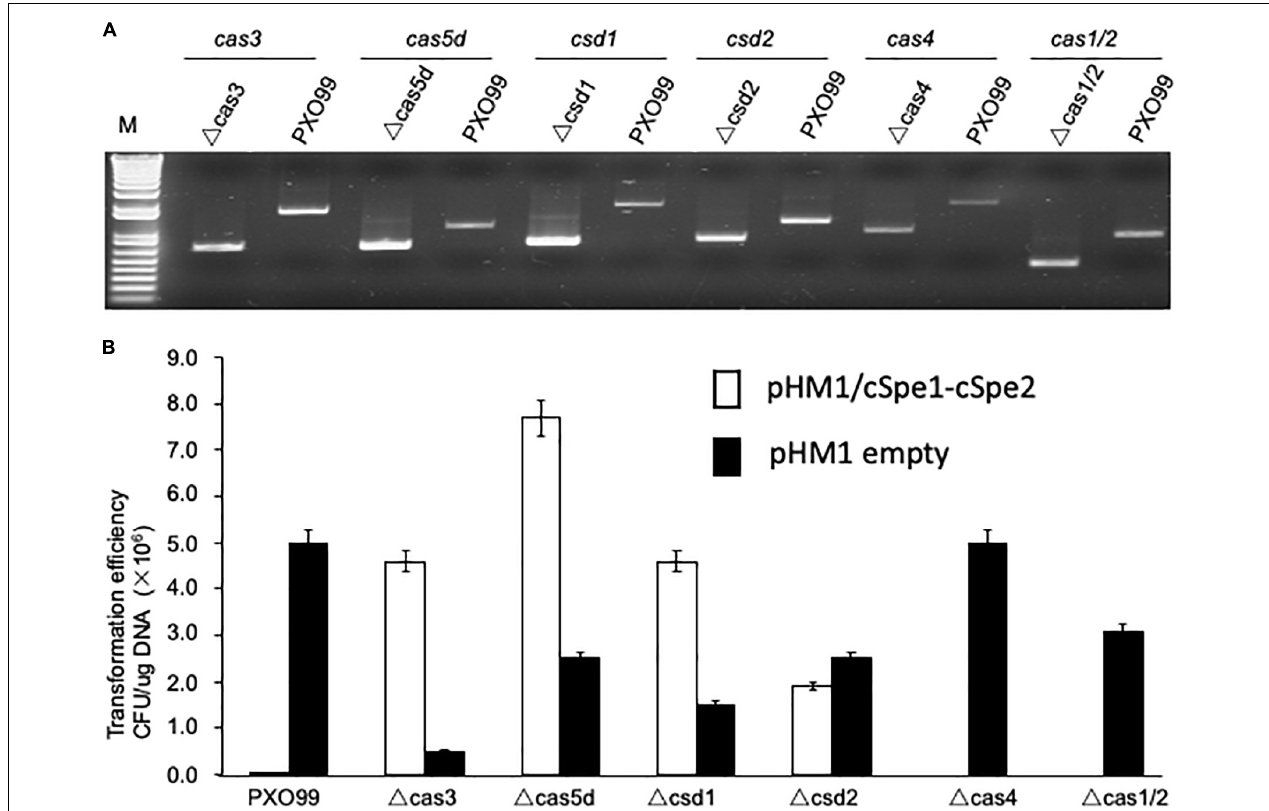
FIGURE 3 | Mutagenesis of Cas genes in PXO99 A strain. (A) PCR verification of Cas gene knockout mutants derived from the PXO99 A strain. (B) Functional analysis of CRISPR in Xoo strains with the specified Cas gene inactivated. The non-targeting plasmid pHM1-XocRNA DR empty was used as a control.